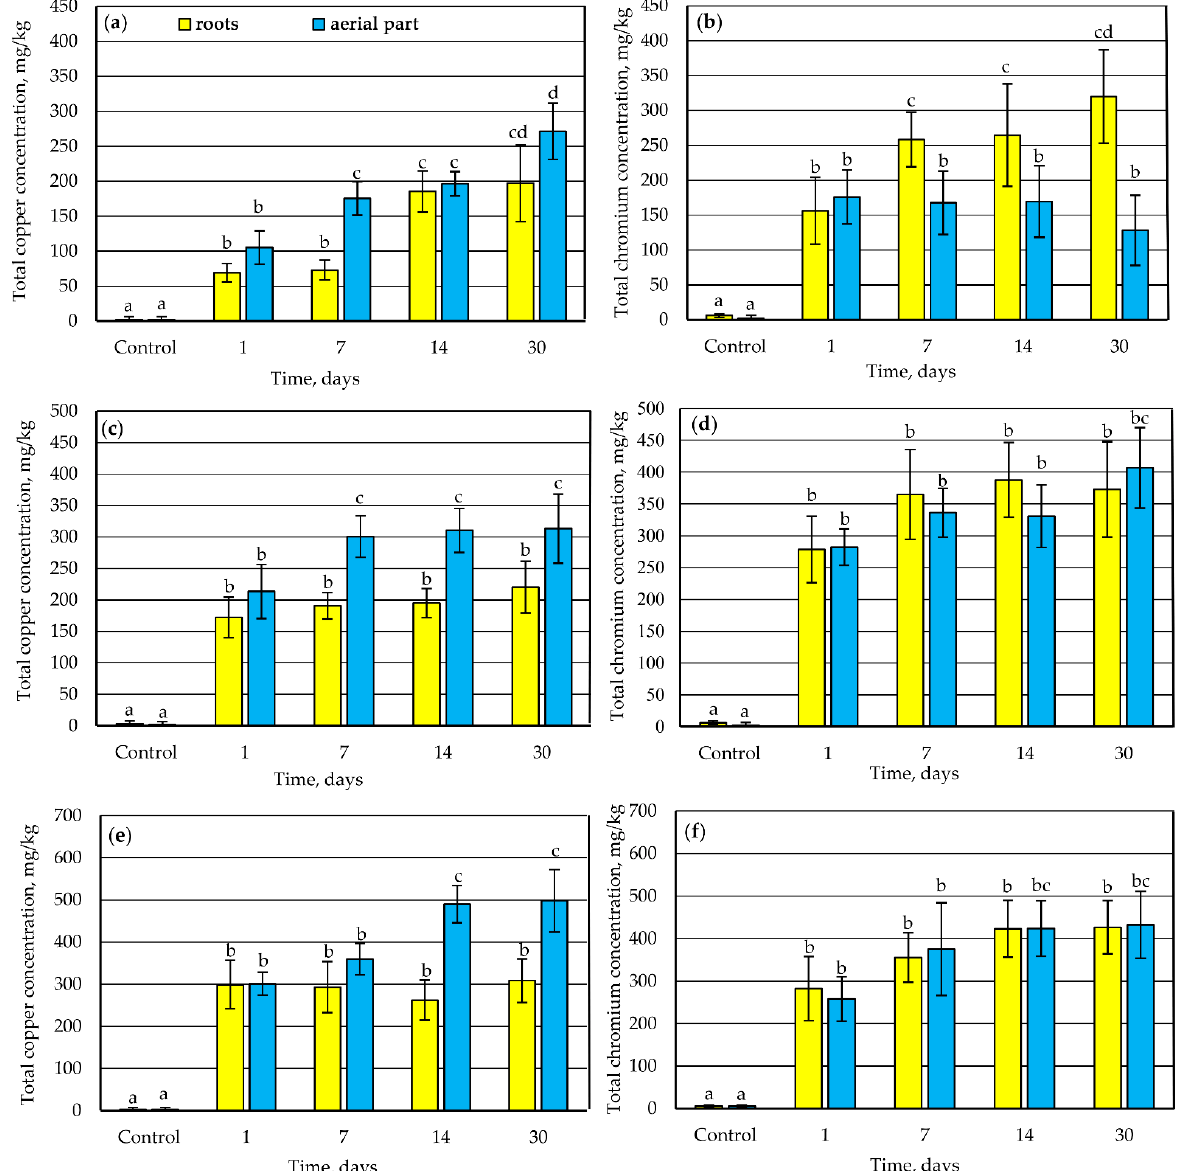
Figure 2. Accumulation of metals by lawn grass during growth at their different concentrations in the soil: ( a ) 50 mg/kg Cu(II); ( b ) 50 mg/kg Cr(VI); ( c ) 100 mg/kg Cu(II); ( d ) 100 mg/kg Cr(VI); ( e ) 200 mg/kg Cu(II); ( f ) 200 mg/kg Cr(VI), ( х ± SD, n = 5) with different letters significantly differ from each other based on Bonferroni corrections at p < 0.05. The concentration of copper in grass increased 2.9 times ( p = 0.0002) from 69.14 ± 13.2 to 197.2 ± 55 mg/kg in the roots and 2.6 times ( p = 0.000003) from 105.2 ± 23.8 to 271.4 mg/kg ± 40.3 mg/kg in the leaves from 1 to 30 days of growth in copper-contaminated soil (50 mg/kg) (Figure 2a). The concentration of chromium in the grass was slightly different from the concentration of copper. Thus, the grass accumulated more quantity of chro- mium than copper in the roots during growth in the presence of 50 mg/kg Cr(VI). The